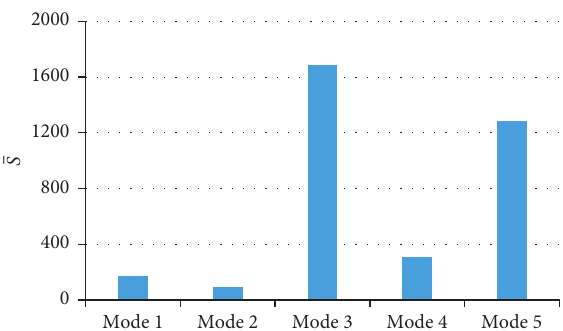
Figure 11: Dimensionless sensitivity of 5 modes with respect to the contact